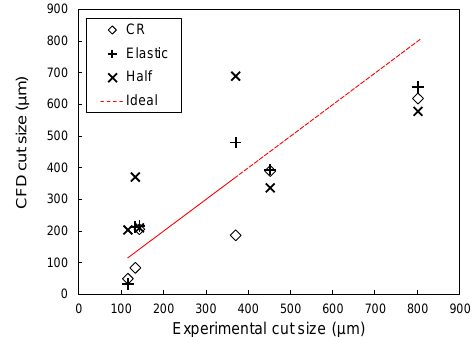
Fig. 7. CFD cut size versus experimental cut size for the CoR